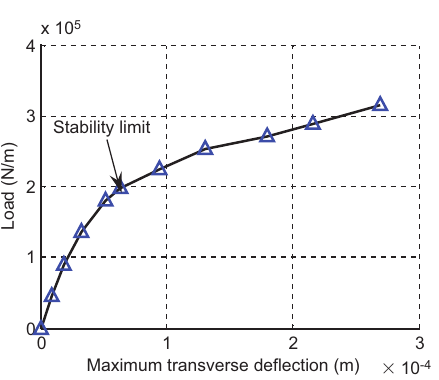
Figure 5 Load defl ection curve for clamped-clamped hybrid curved plate.